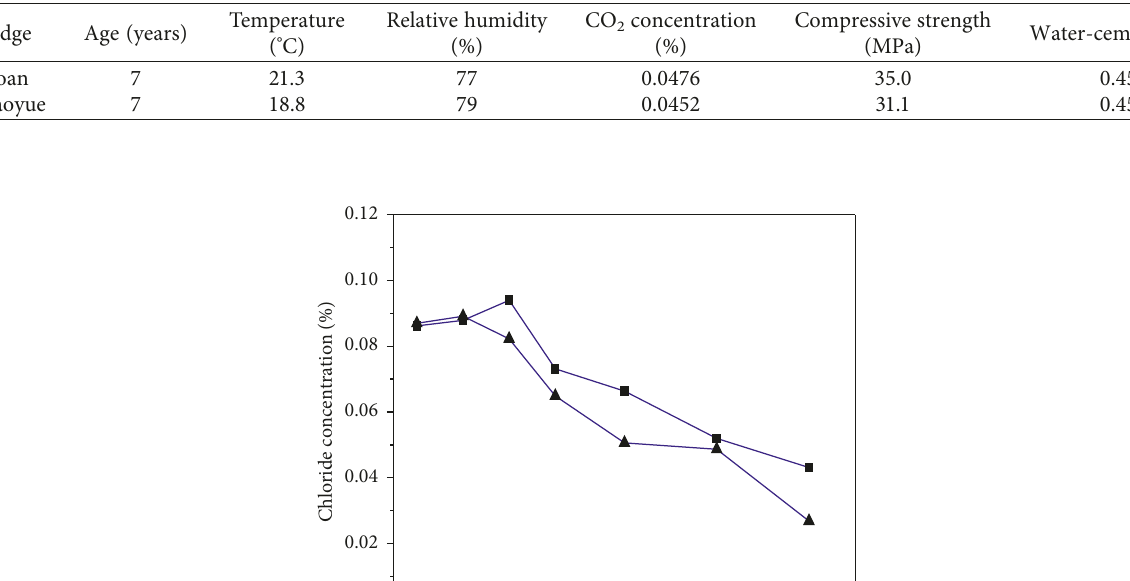
Table 9: Field condition of the Baoan bridge and the Xiaoyue bridge.